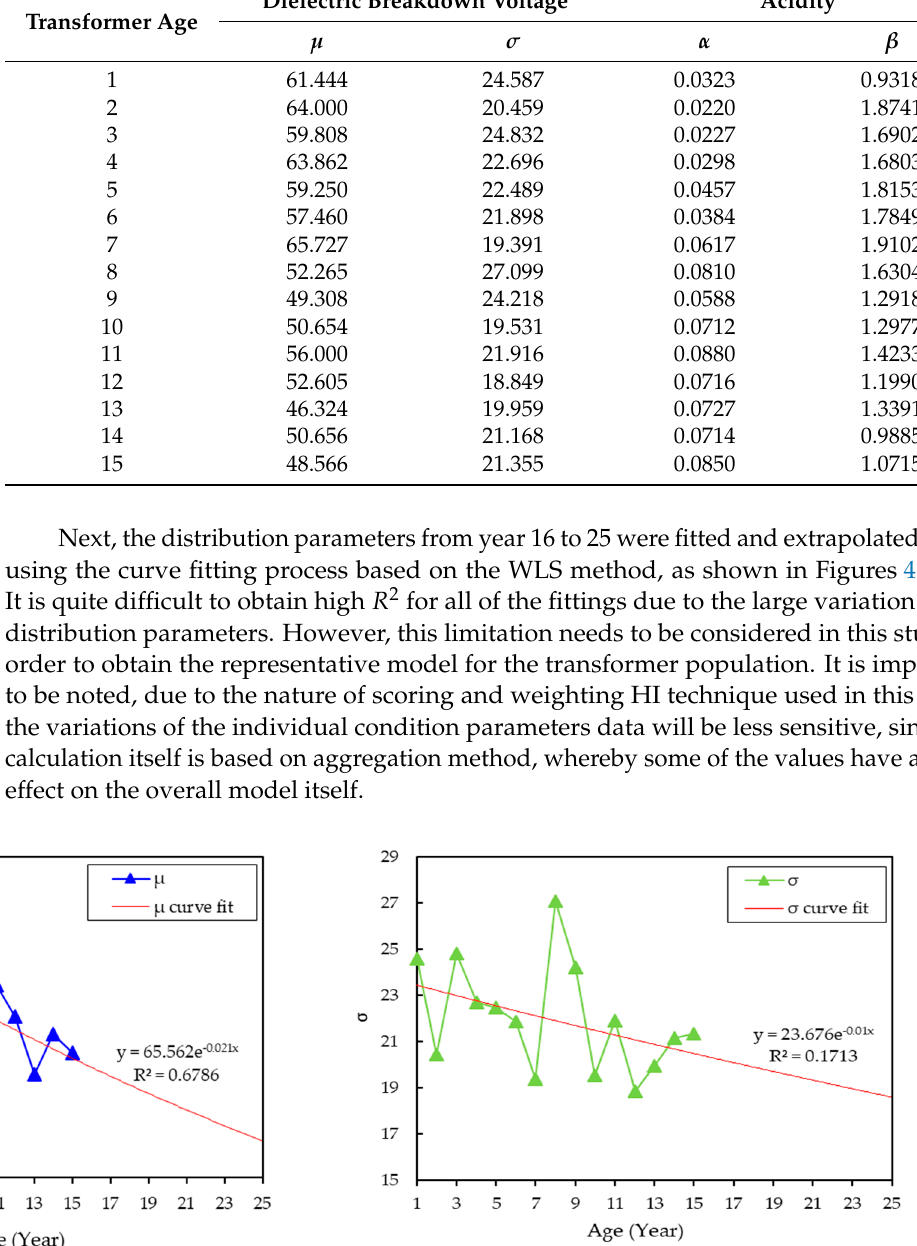
Figure 5. Parameters estimation for acidity based on Weibull distribution model. The exponential-based model was chosen for the curve fitting process, since it can provide the highest (cid:1844) (cid:2870) when compared to other models. For dielectric breakdown voltage data, the fittings of (cid:2020) and (cid:2026) exponentially decrease as the transformer age is increased. Based on the extrapolation, the (cid:2020) and (cid:2026) at year 25 are 35.005 and 18.434, respectively, as shown in Table 3. For the acidity data, the fitting of (cid:2009) increases exponentially as the transformer age increases. On the other hand, the fitting of the (cid:2010) shows a slight decrement trend. Table 3 presents the estimated distribution parameters for dielectric breakdown voltage and acidity from year 16 to 25. Next, the individual condition parameters data for the next 10 years were computed while using the estimated distribution parameter through ICDF, as in Equations (19) and (20) for validation purpose. Table 3. Estimated distribution parameters for dielectric breakdown voltage and acidity. Transformer Age Dielectric Breakdown Voltage